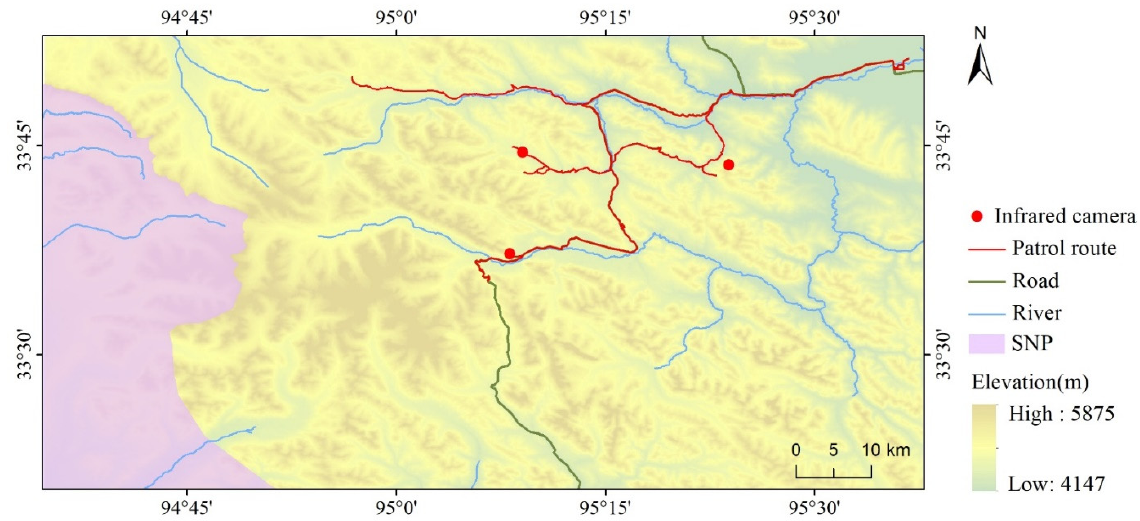
Figure 2. The patrol route of the research team in Sobchaye.